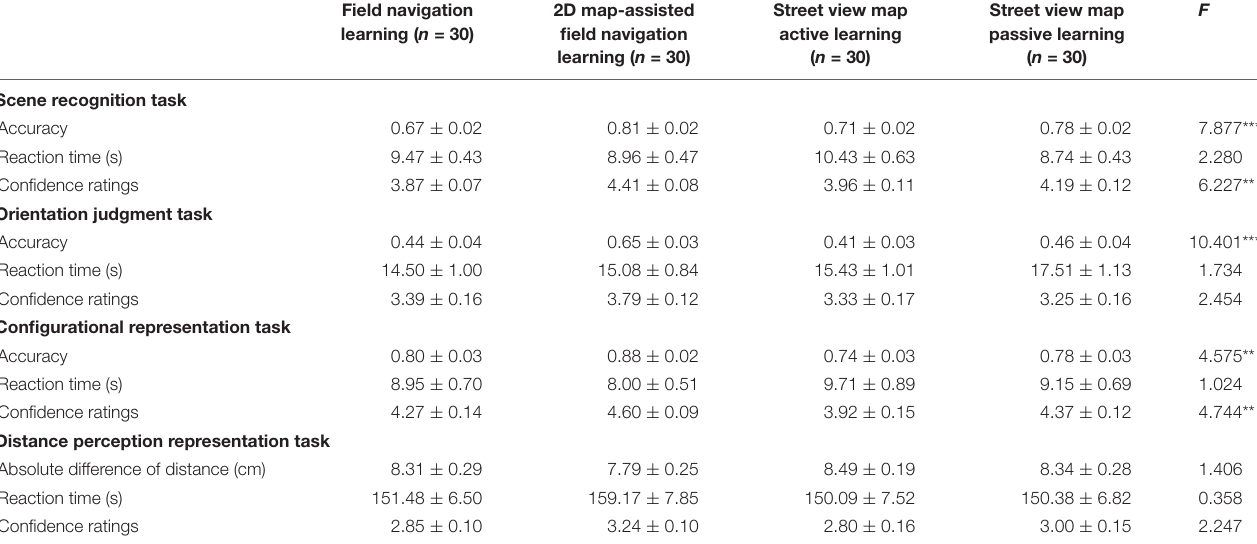
TABLE 1 | Differences among learning methods in terms of performance on different spatial knowledge tasks (Mean ± SE).